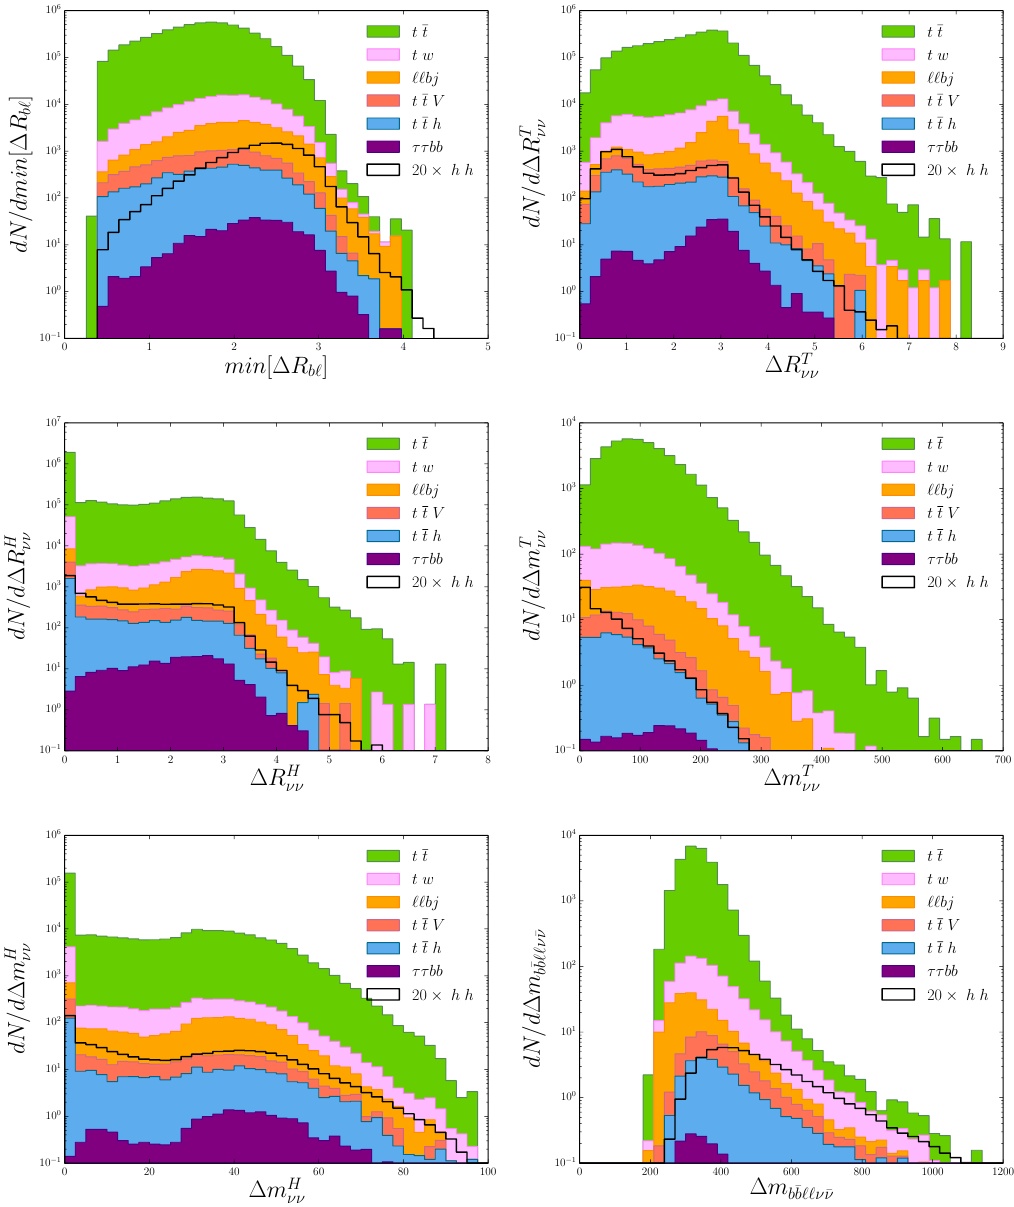
(right, top), ∆ R H νν with reconstructed neutrino momenta using Higgsness (right, b ¯ b‘‘ν ¯ ν